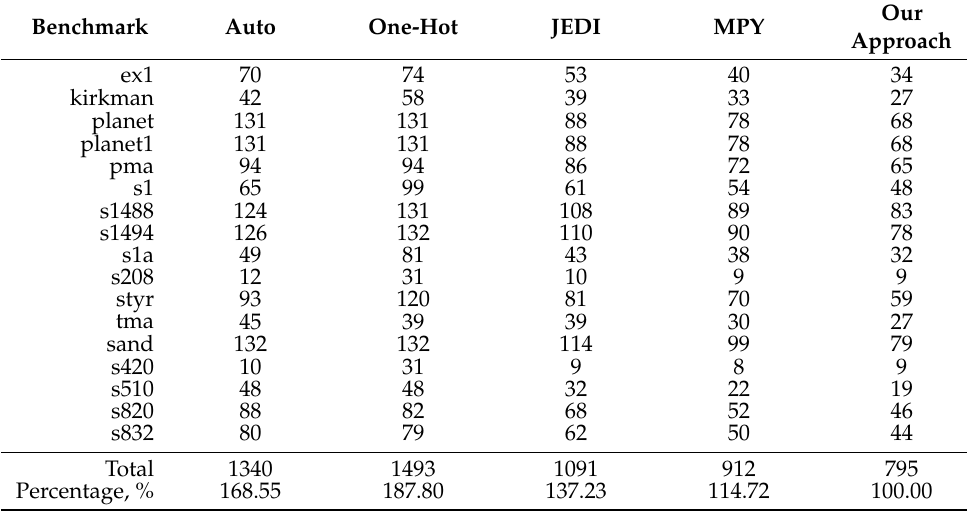
Table 12. Experimental results (numbers of LUTs for